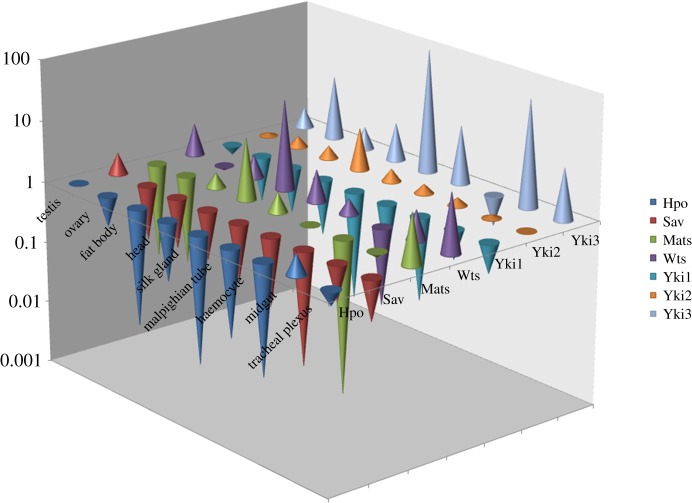
Relative abundance of major genes in the Hippo pathway in diverse tissues at day 3 of the fifth instar stage. The expression level of BmHpo in testis is assumed to be 1. The values of the 2−ΔΔCT were transformed into Log 10 data for analysis.